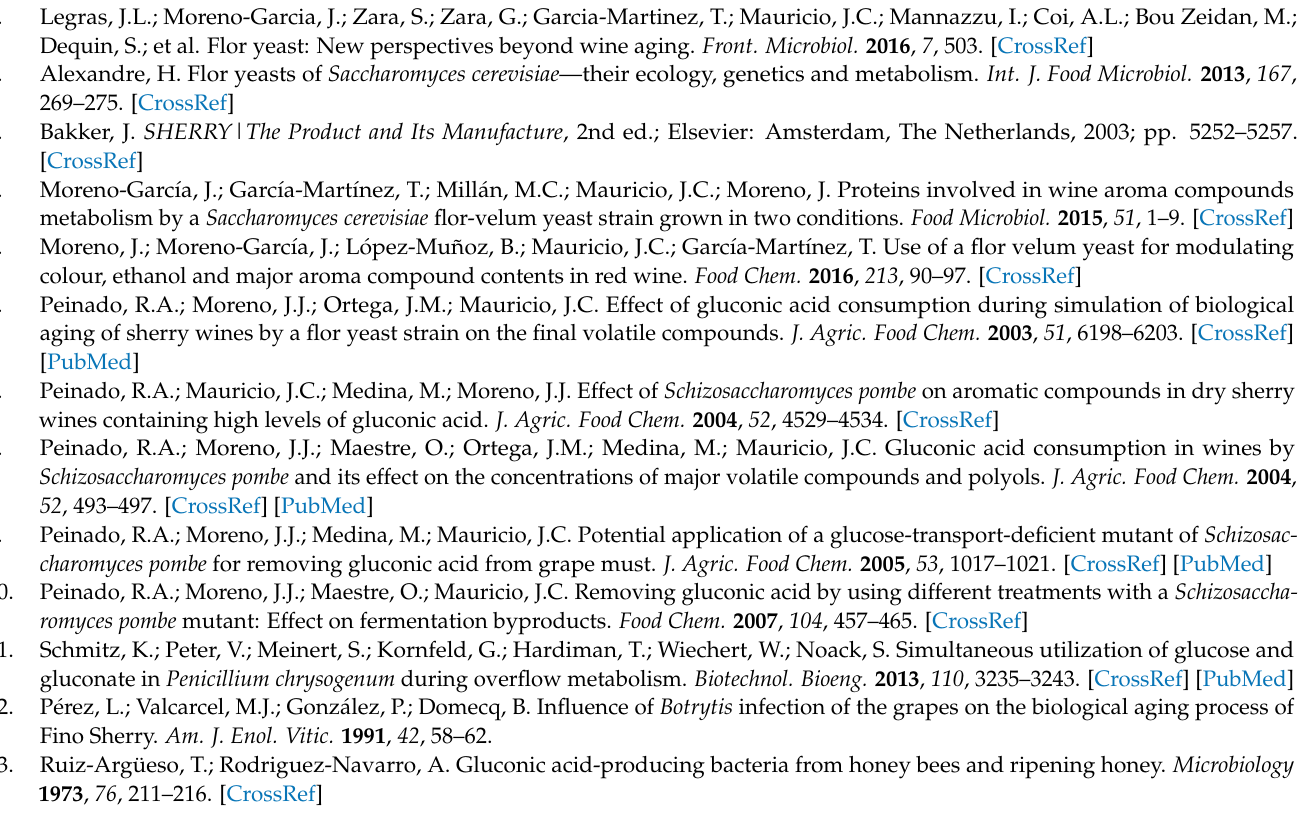
scores. Match status (number of metabolites in given data sample/total number of metabolites in the pathway), p value, − log( p ), Holm p value, false discovery rate (FDR) of all generated pathways, Table S2: Average concentration ( µ mol/g) and standard deviations (SD) of endomentabolites detected in all conditions. Different letters (A–C) indicate homogeneous groups (HG) statistically significantly differing in values of concentration of the endometabolite among the conditions ( p < 0.05,